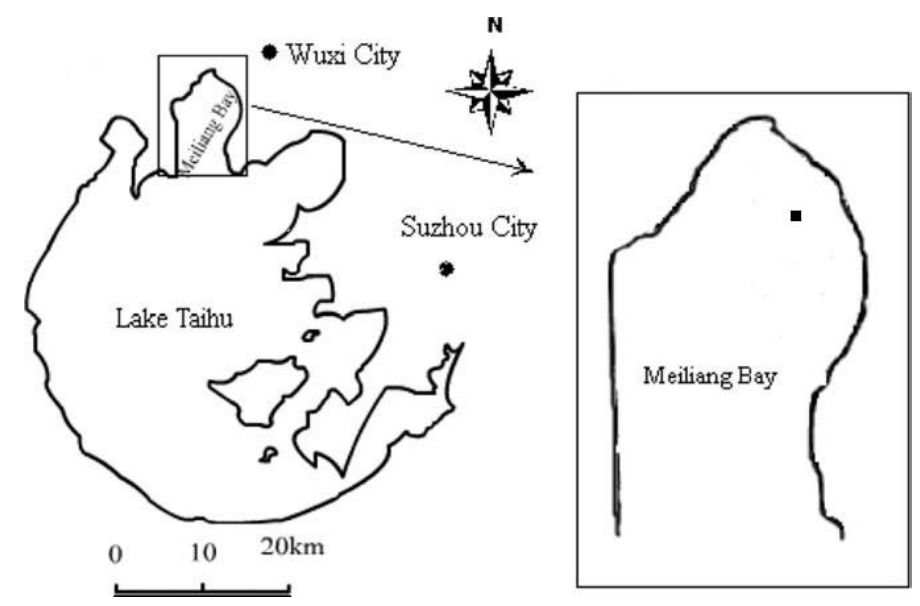
FIGURE 1. The sketch map of Lake Taihu and sampling station of Meiliang